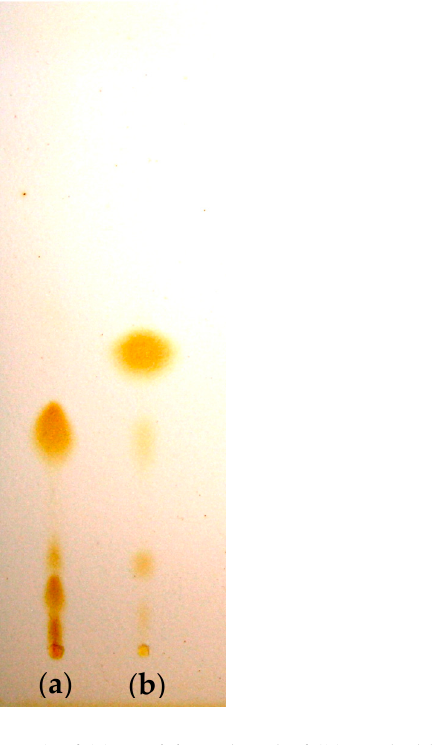
Figure 3. Thin layer chromatography (TLC) of ( a ) B. glabra oil and of ( b ) methyl biodiesel. Eluant: hexane-EtOAc (95:5); Dyeing reagent: iodine vapor.